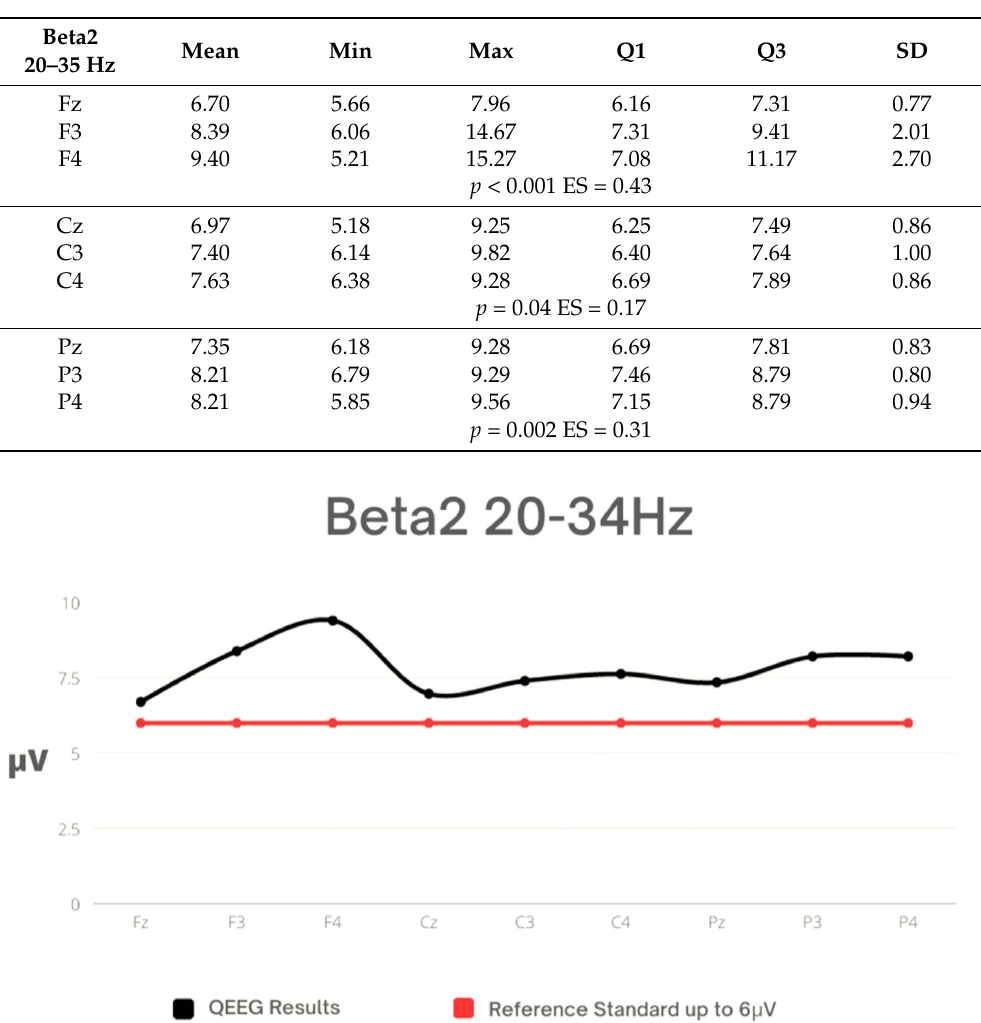
Figure 6. Mean values for Beta2 against the reference